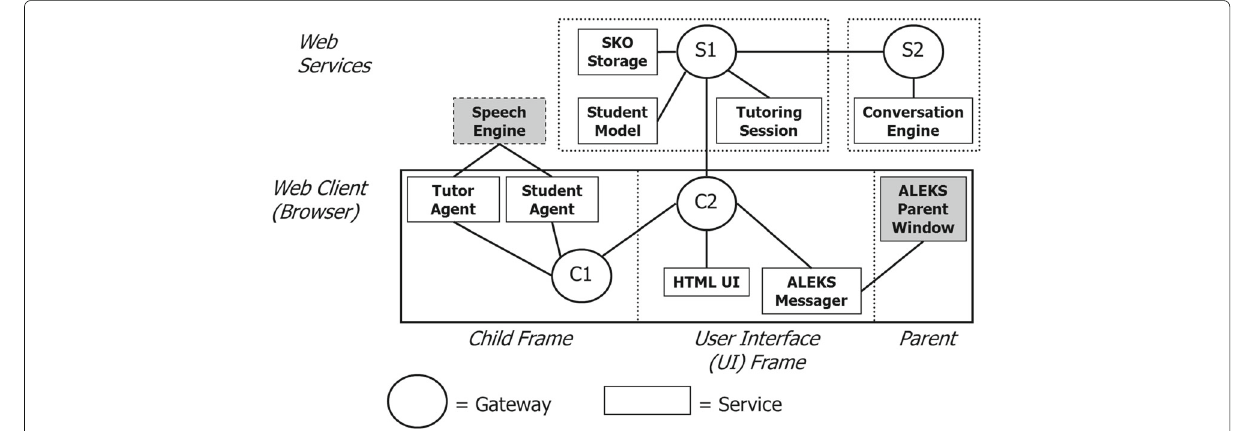
Fig. 5 SKOPE-IT core service structure